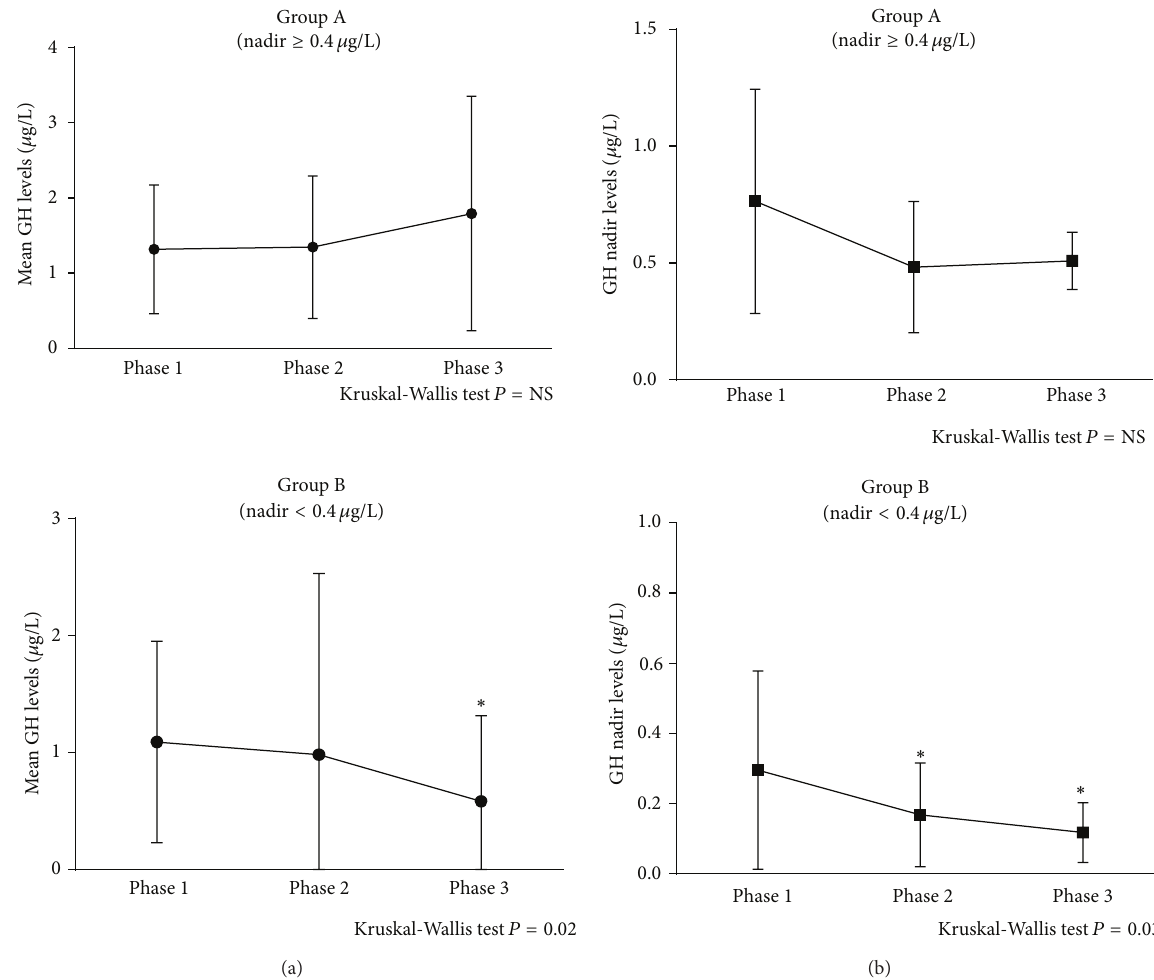
Figure 1: (a) Mean GH levels in basal condition, evaluated as the mean of at least three consecutive samples, in patients of group A (i.e., GH nadir ≥ 0.4 mcg/L, upper) and group B (i.e., GH nadir < 0.4 mcg/L, lower). Patients of group B showed mean GH levels at long-term follow- up (phase 3) significantly lower than at the time of remission (phase 1), whereas no difference was observed in group A. ∗ 𝑃 < 0.05 versus phase 1. Values are expressed as mean ± SEM. (b) Mean GH nadir, defined as the lowest GH value at any time after glucose administration (2h-OGTT), in patients of group A (i.e., GH nadir ≥ 0.4 mcg/L, upper) and group B (i.e., GH nadir < 0.4mcg/L, lower). Patients of group B showed mean GH nadir levels atlong-term follow-up (phase 3) and at the time of the last assessment available with the GH assay standardized to IS 80/505 (phase 2) significantly lower than at the time of remission (phase 1), whereas the decrease did not reach statistical significance in patients of group A. ∗ 𝑃 < 0.05 versus phase 1. Values are expressed as mean ±